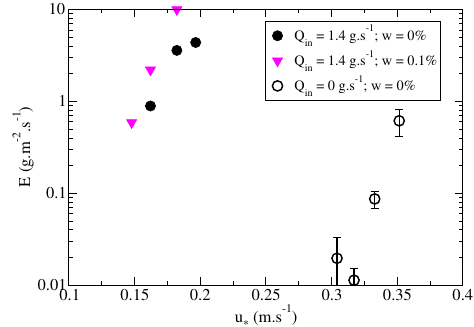
Figure 6. Impact erosion rate as a function of the friction speed for two di ff erent liquid content, w = 0 and 0 . 1% respectively. The incoming mass flow rate is Q in = 1 . 4 g. s − 1 . Open symbols correspond to data obtained for the aerodynamic erosion